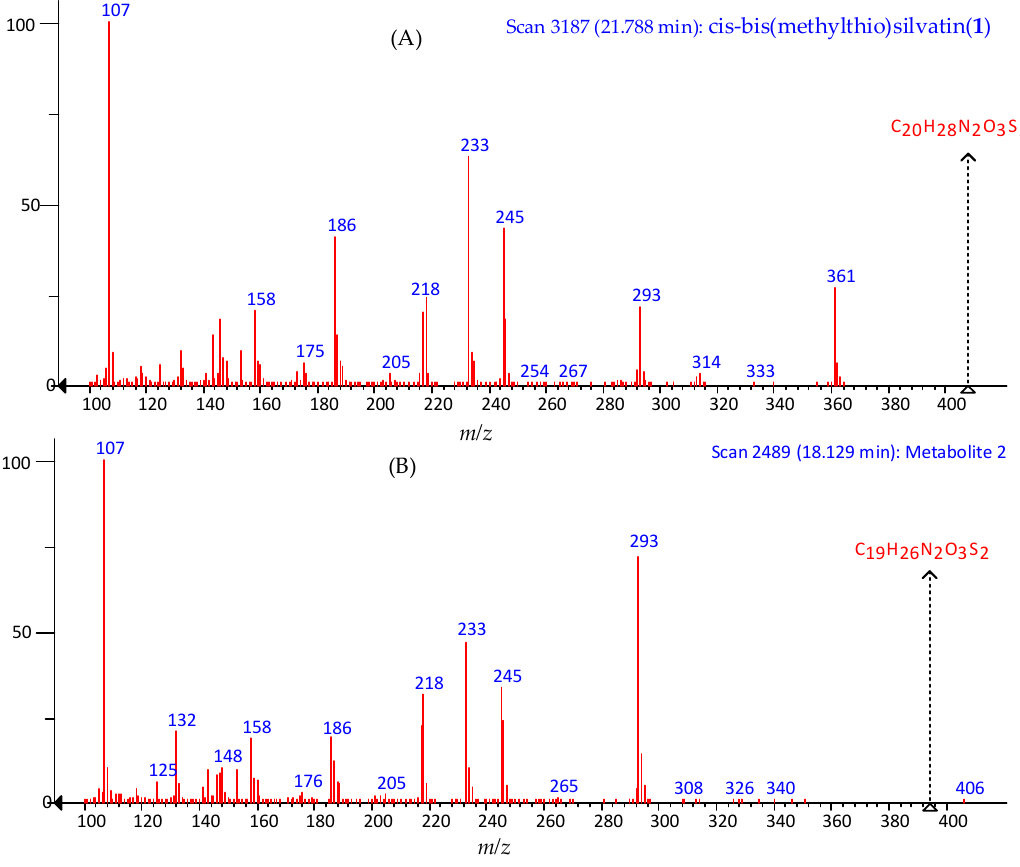
Figure 5. Comparison of 70 eV electron impact (EI) MS of the NMR-characterized cis - bis(methylthio)silvatin( 1 ), A , with the spectrum of the unidentified target metabolite 2, B